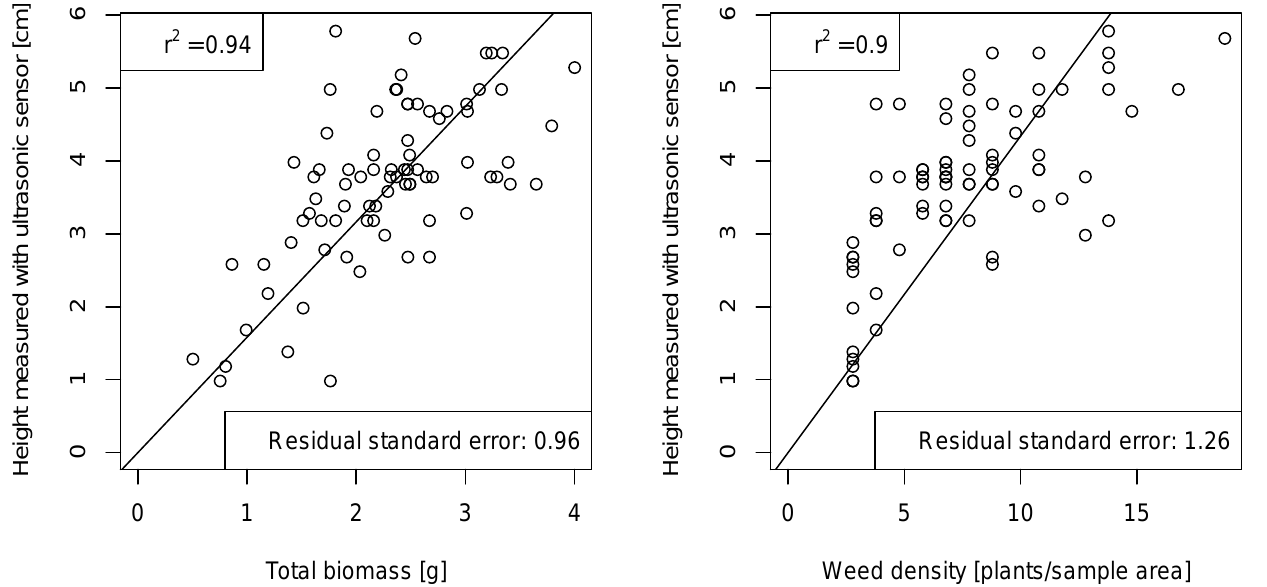
Figure 5. Simple linear regression plots for measured ultrasonic sensor height to weed density and total biomass (crop and weed).